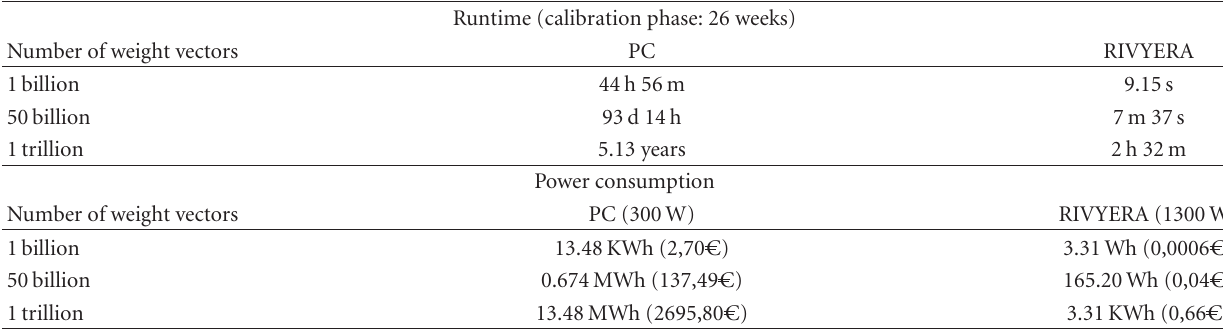
Table 3: Comparison of PC and